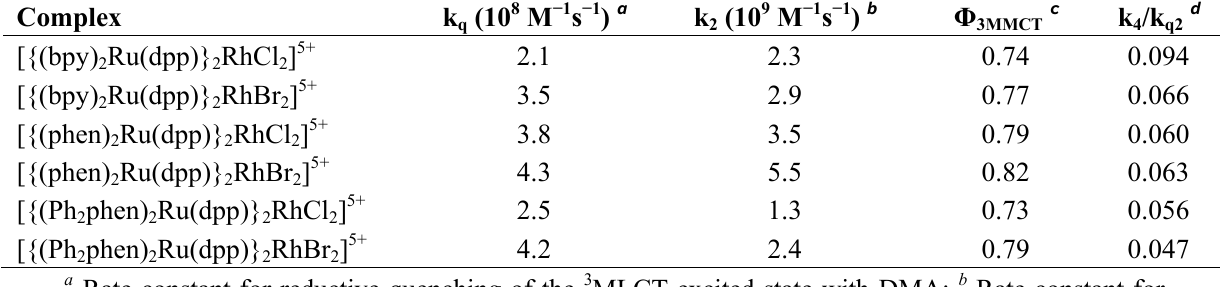
Table 3. Rate constants for Rh reduction for [{(TL) complexes from the 3 MLCT and 3 MMCT excited